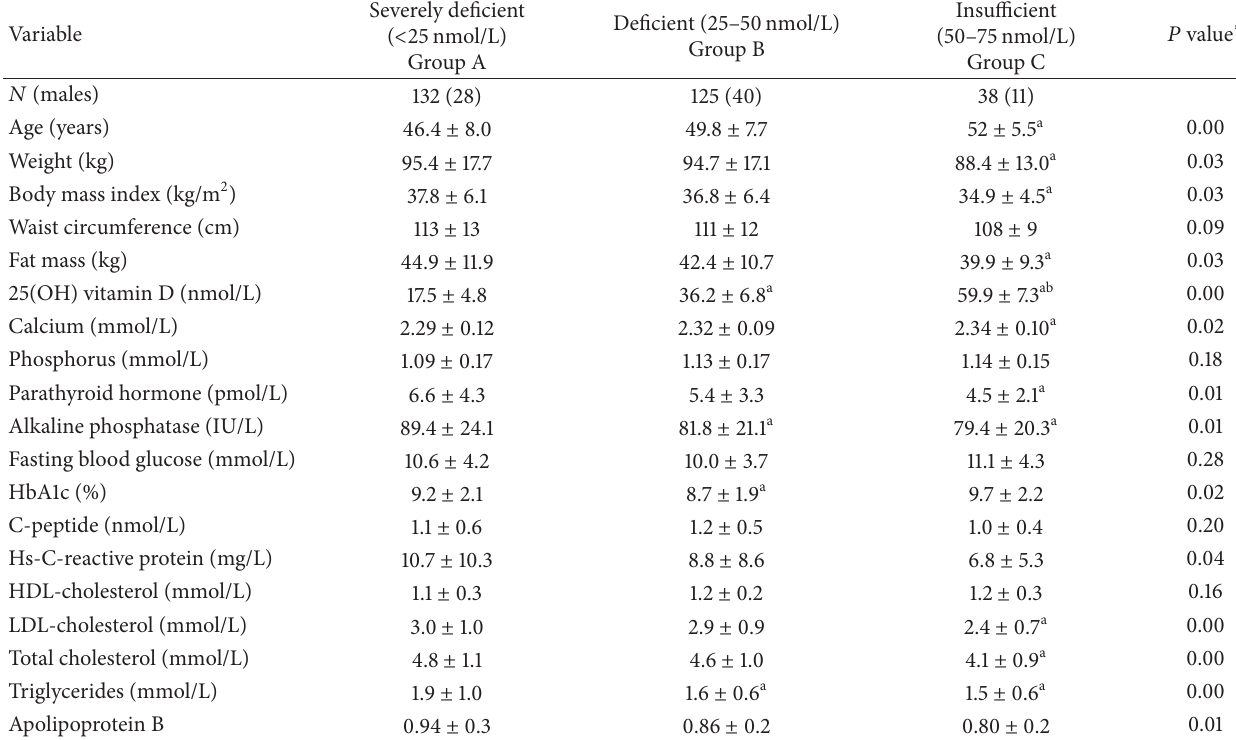
Table 3: Demographic, anthropometric, and laboratory variables in subgroups with different serum 25(OH) vitamin D cut-off